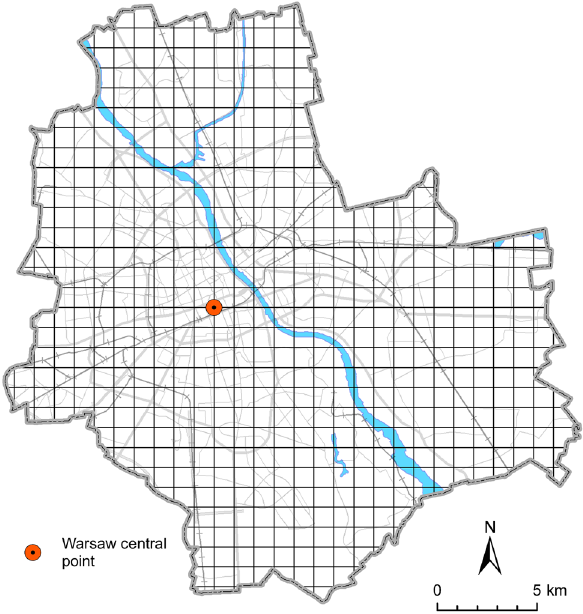
Figure 2. The grid of squares searched for presence signs to assess red fox distribution in Warsaw in 2005– 2012. The Palace of Culture and Science, assumed as the most central point of the city is